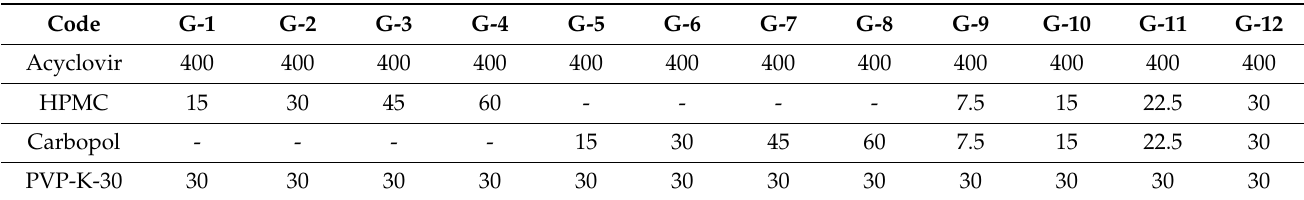
Table 6. Composition (in mg) of acyclovir granules.